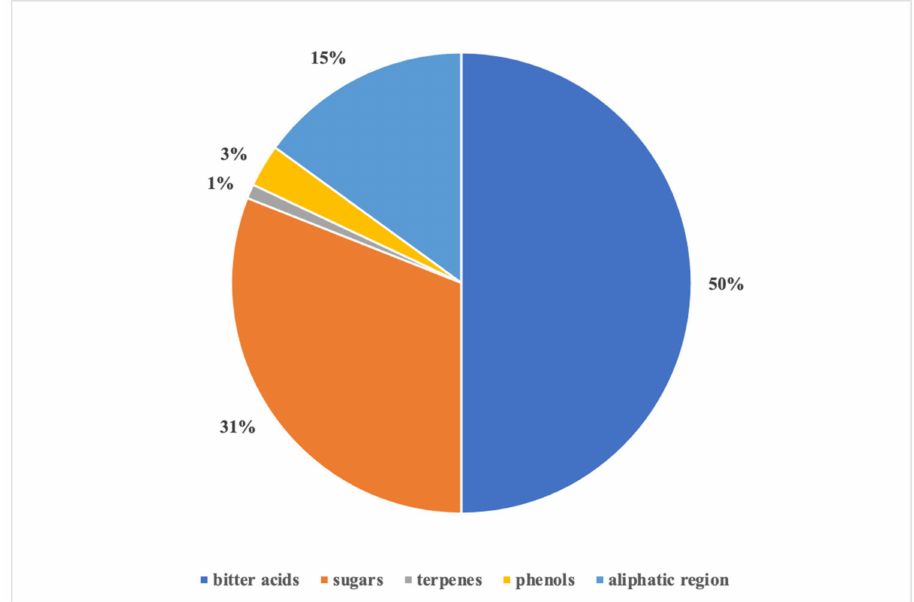
Figure 2. Relative composition (area %; n = 3) of hop extract by 1 HNMR